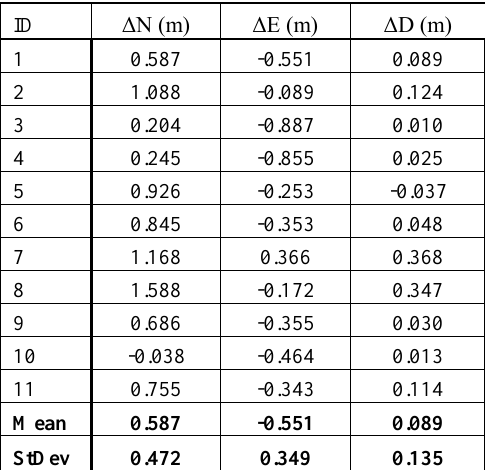
Table 7. Standard deviations of the extracted points